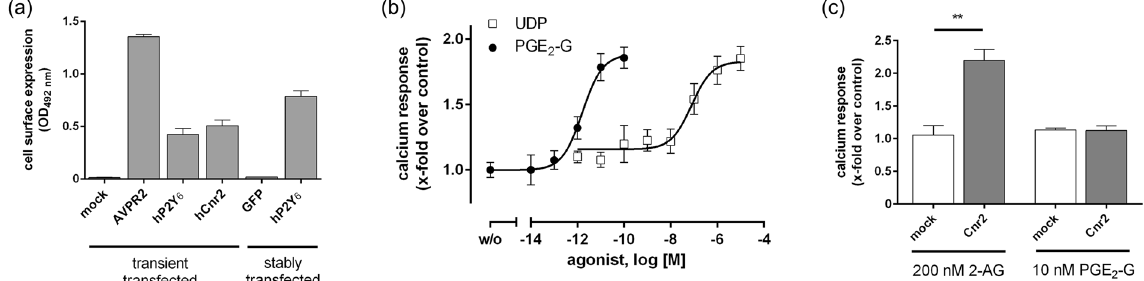
Figure 2. Effect of UDP and PGE2-G on transfected HEK293 cells. ( a ) HEK293 cells were transiently transfected with either HA-tagged version of hP2RY6 and hCNR2 and the expression levels of receptors were measured by a cell surface ELISA (see Methods ). As a positive control the human V2-vasopressin receptor (hAVPR2), N-terminally tagged with an HA tag, was used. eGFP and hP2RY6_eGFP were stably transfected in HEK293 cells and cell surface expression was measured. ( b ) HEK293 cells transfected with P2RY6 were used for intracellular Ca 2 + measurements (see Methods ). Indicated concentrations of UDP and PGE 2 -G revealed EC 50 values of 78.3 ± 6.7 nM and 1.2 ± 0.08 pM, respectively. ( c ) In contrast to PGE 2 -G, 200 nM of 2-AG elevated intracellular Ca 2 + in CNR2-transfected cells. RFU for mock-transfected cells were 1,832 ± 299. All data are given as means ± SEM of three independent experiments each performed in triplicate. * p < 0.05, ** p < 0.01, *** p < 0.001 (paired Student’s t